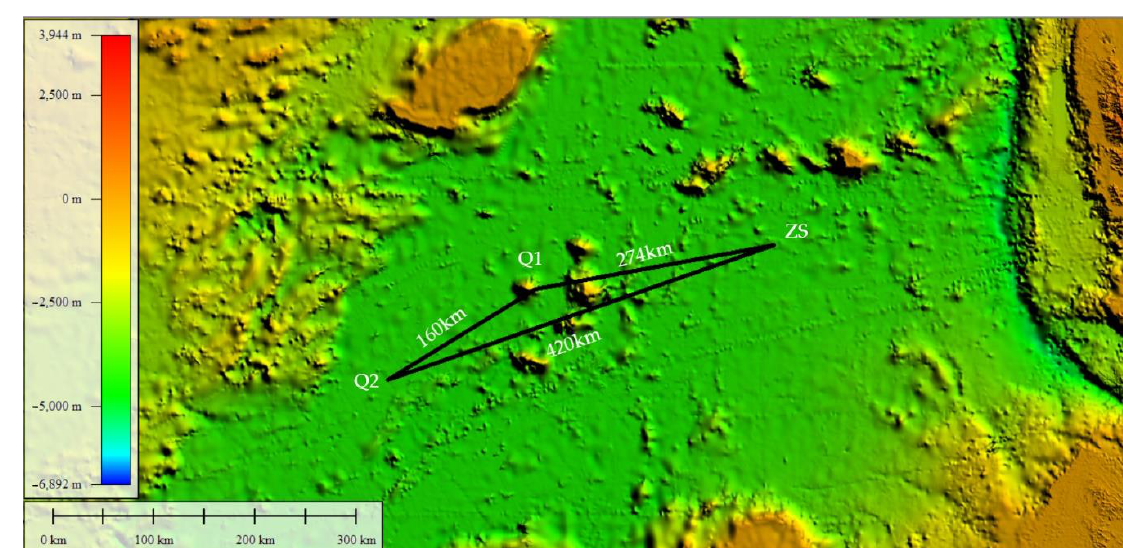
Figure 7. Experimental area.